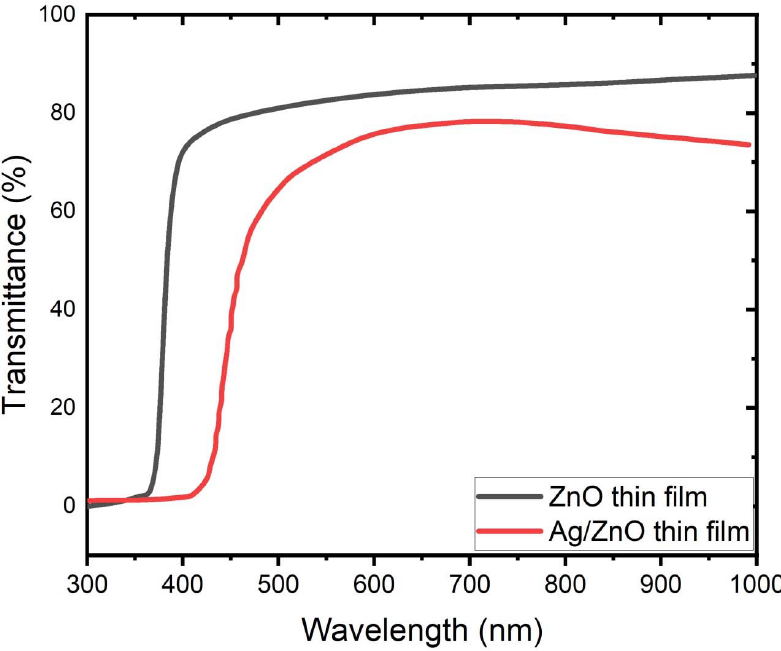
Figure 4. Absorbance spectra of ZnO thin film before and after being embedded with Ag thin films . Figure 5 displays the PL spectra of thin films, which were calculated using an exci- tation wavelength of 325 nm and an emission spectrum that ranged from 360 to 410 nm. The samples’ PL spectra show a single violet luminescence peak with a center wave- length of 378 nm. It has been reported that thin ZnO films produced on quartz via PLD emit violet fluorescence, which represents a mixture from the oxygen or zinc vacancies. In other words, in the case of Ag/ZnO nanocomposite thin film, the interface traps be- tween Ag nanoclusters and ZnO grains that exist at the grain boundaries generate violet light from the electronic transition between CB and VB. Additionally, the emission spec- tra showed a substantial violet emission at 382 nm, which was probably generated by radiate defects brought on by interface traps at the grain boundaries. After Ag was added, this band edge emission peak migrated slightly to a higher value, indicating that the optical bandgap had shrunk. Besides, the presence of oxygen vacancies that inter- acted with Ag doping also had an impact on the location and intensity of this PL emis- sion. Since Ag 2+ ions take the position of Zn + ions in the high concentration of Ag-doped ZnO, the peak’s intensity is lower than it is for pure ZnO [35–38].